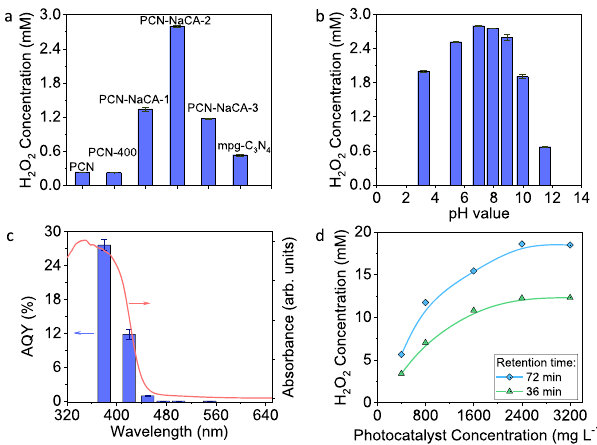
Fig. 3 Solar-driven H 2 O 2 production performance. a Comparison of the